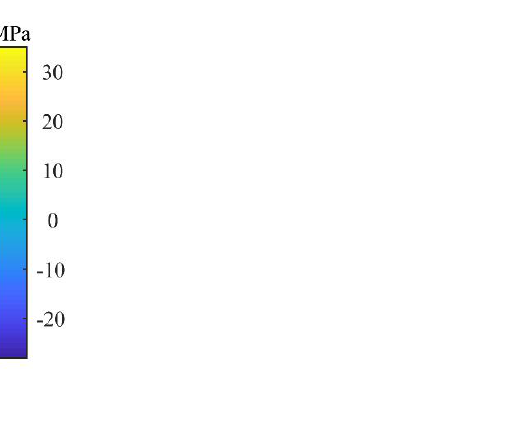
Figure 17. Simulated wafer residual stress when the division number was 525 using regularization method. The regularized method with continuity constraints was robust to the number of subareas of the wafer.